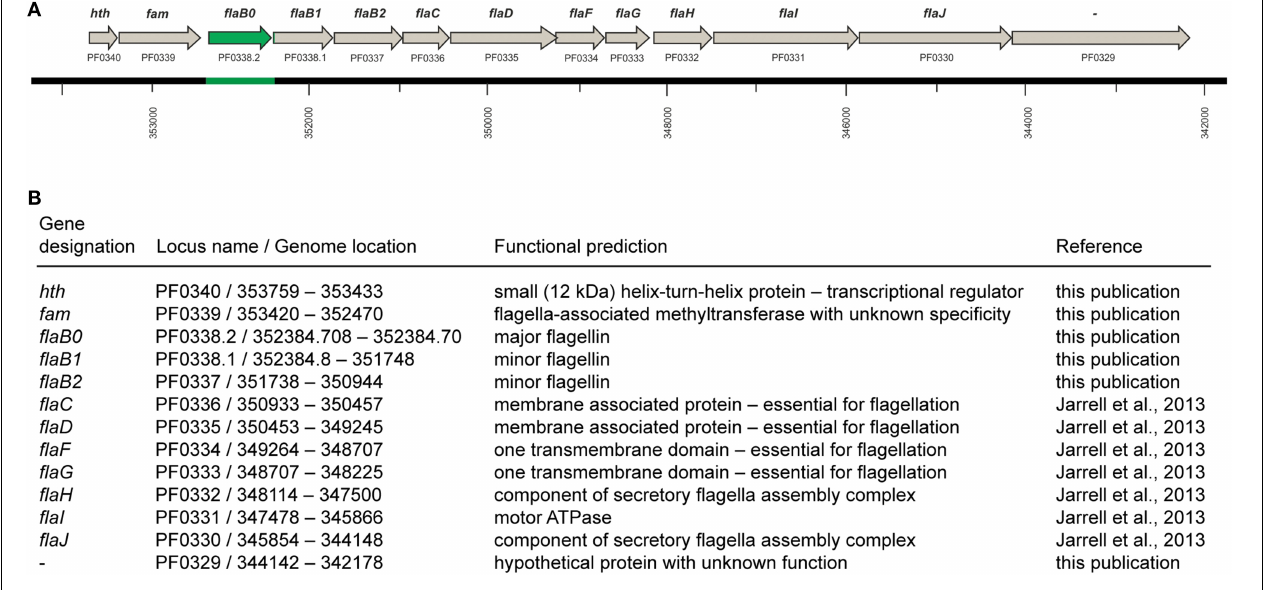
transcribed from the negatively oriented DNA strand, but are shown here from left to right for easier orientation. (B) Functional predictions of the genes shown in (A)